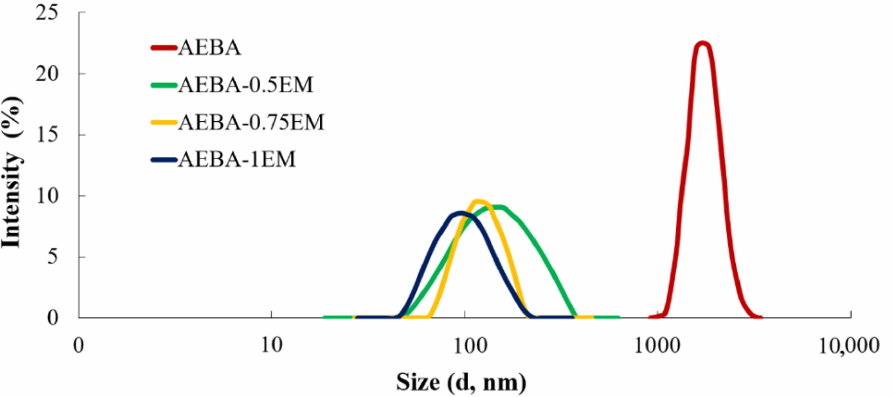
Figure 5. Particle size distribution of AEBA and AEBA-EM, determined by